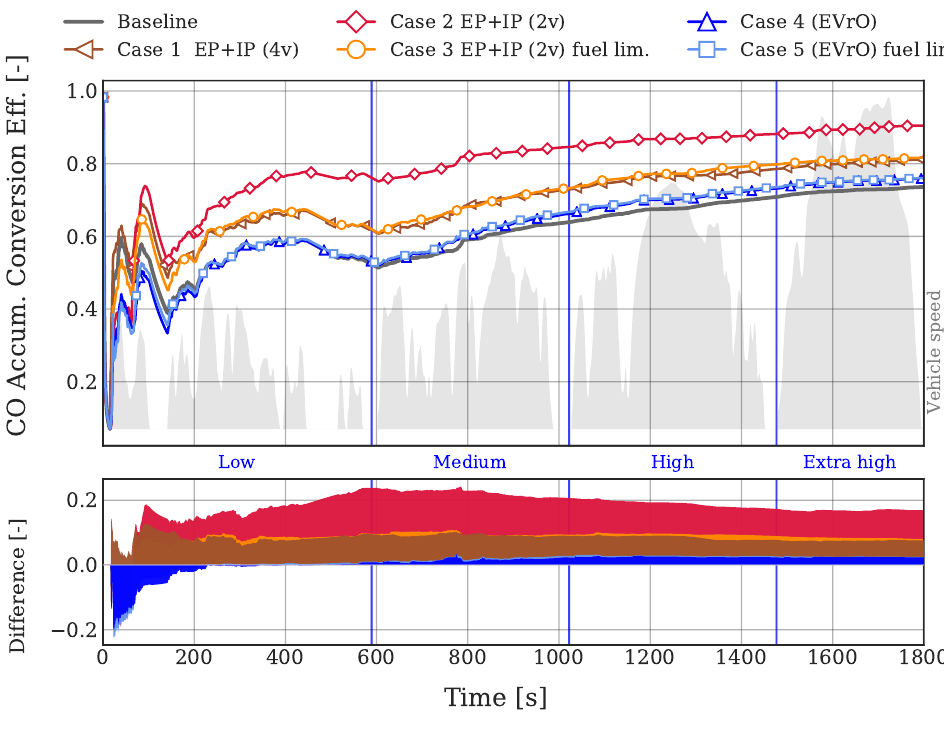
Figure 13. WLTC CO accumulated conversion